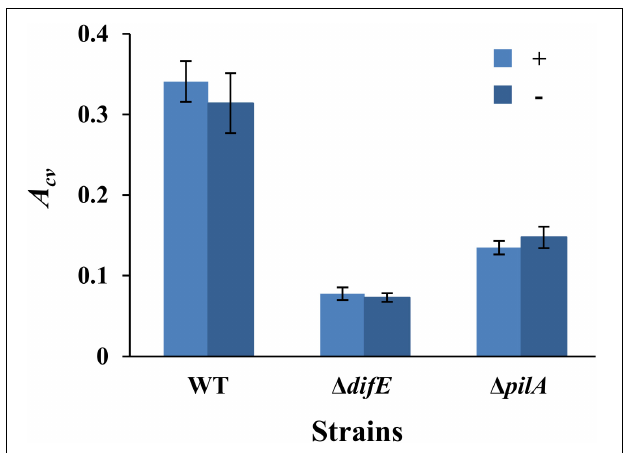
FIGURE 1 | Myxococcus xanthus SBFs with or without overnight seeding. Shown are the SBF amounts represented by average A cv values with standard deviations from three independent experiments, each conducted in quadruplicates. SBFs were formed with (+) or without (-) overnight seeding. The strains were DK1622 (WT), YZ603 ( (cid:49) difE ), and YZ690 ( (cid:49) pilA